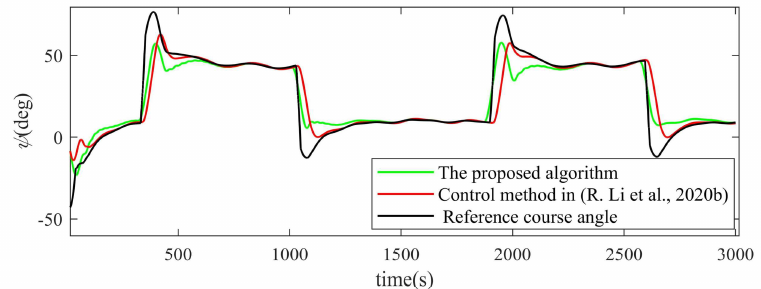
Figure 7. Comparison of rudder angle: proposed algorithm and control method in [32]. For the quantitative purpose, some popular performance indexes (Equation (32)) are utilized to evaluate the comparison result [18], e.g., the mean absolute error (MAE) and the mean absolute control effort (MAC). MAE reveals the stabilizing performance of the control system. MAC indicates energy consumption. The specific data are shown in Table 3. It can be observed that the proposed control algorithm has more advantages in many aspects.